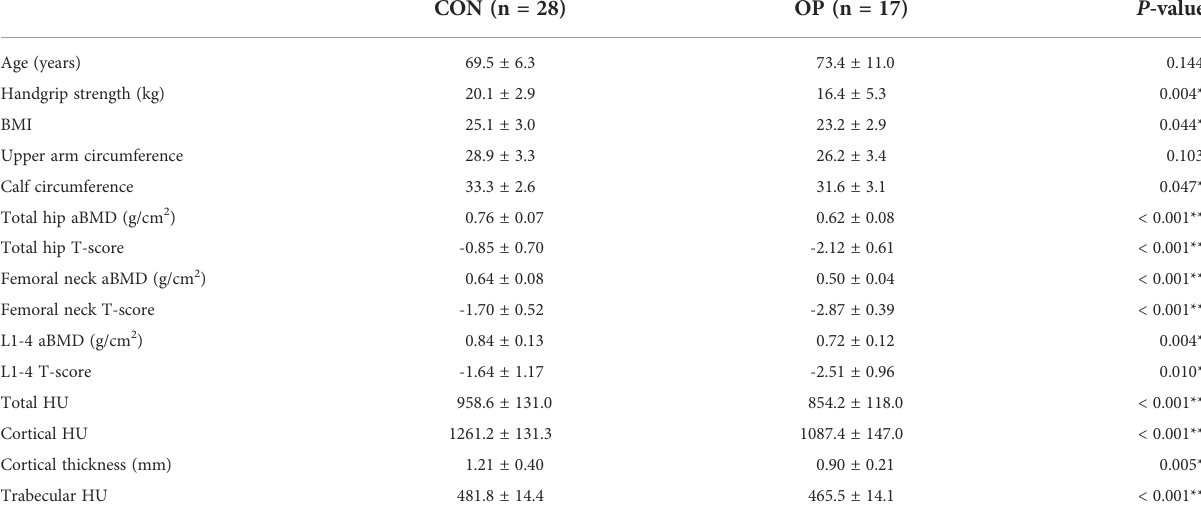
TABLE 2 Differences of demographic features, BMD, and local radial forearm bone quality between two